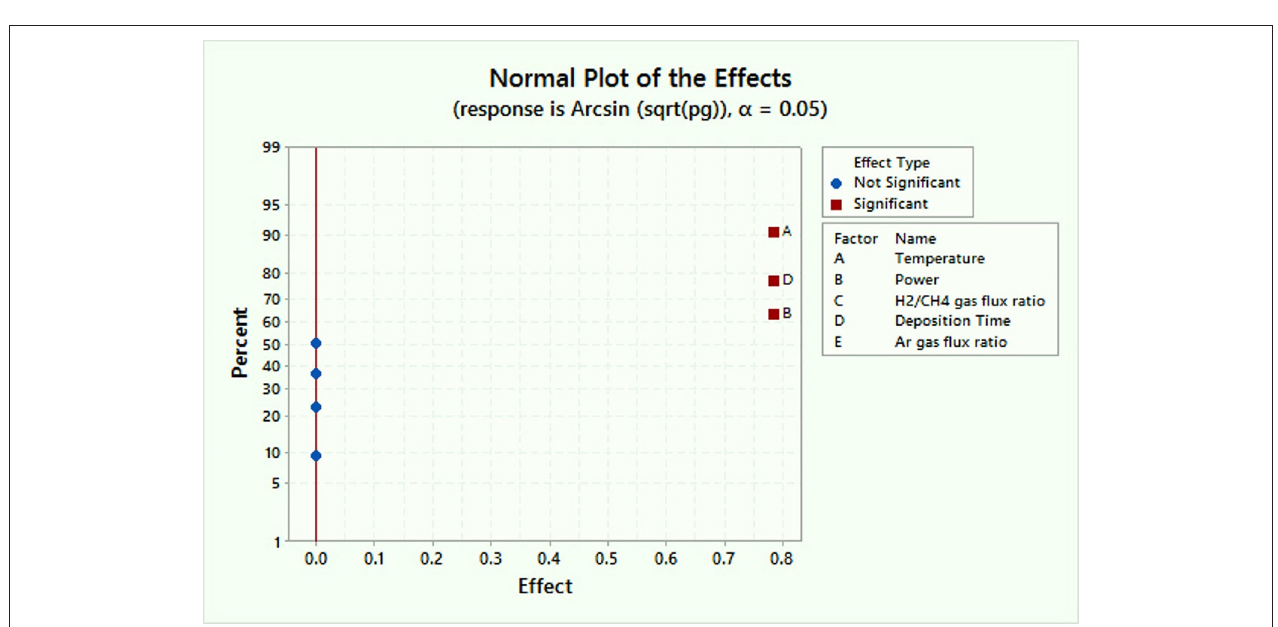
FIGURE 4 | Normal plot of effects. Factors “A”, “B,” and “D” are indicated as significant